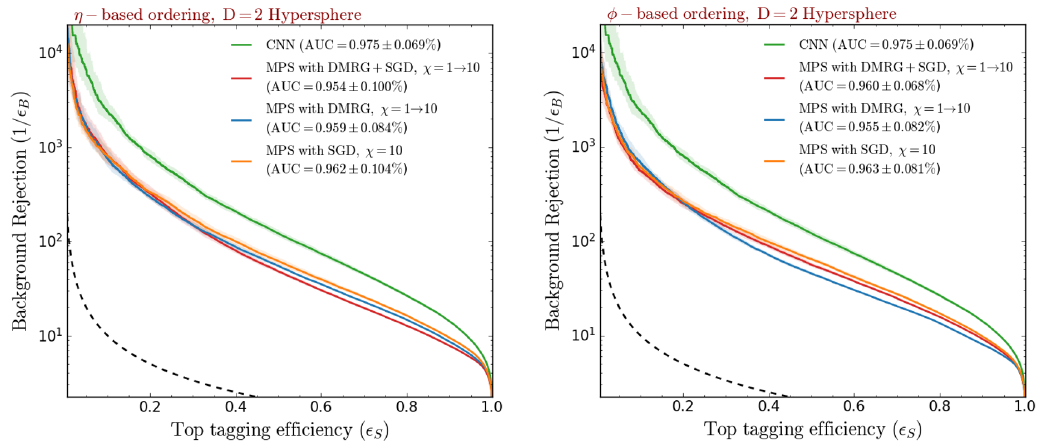
Figure 12 . The left panel shows ROC curves for convolutional and MPS network classifiers with η -based ordering, and the right panel shows the same for φ -based ordering. The green, red, blue and orange curves represent CNN, MPS-classifier trained with DMRG+SGD algorithm, DMRG algorithm, and SGD algorithm. The shaded area shows the statistical uncertainty defined same as figure 9. The dashed black curve represents the random